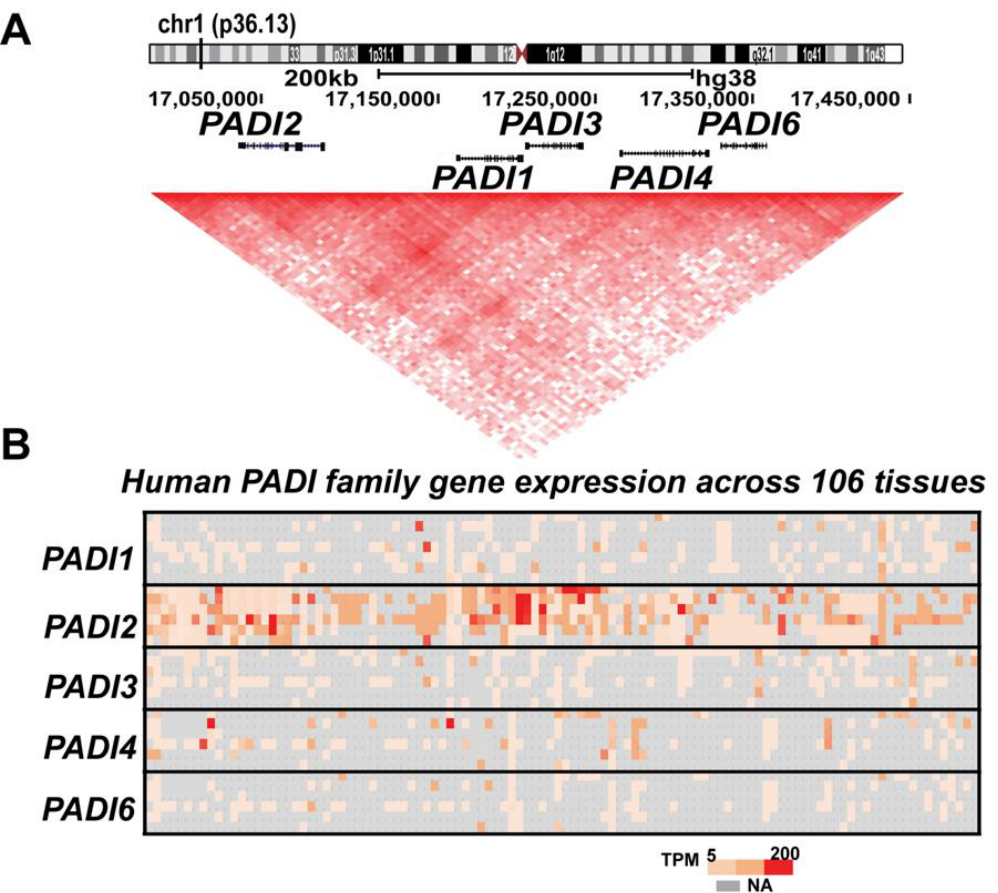
Figure 2. Human PADI gene family. ( A ). Five human PADIs genes ( PADI1 , PADI2 , PADI3 , PADI4 and PADI6 ) are present in the p36.13 of chromosome 1. Among the family members, PADI2 gene is the only one in reverse direction. PADI loci encompasses the same topological associated domain (TAD) in T47D breast cancer cells. ( B ). PADI2 is widely expressed among family members. Heatmap representing the basal expression level of all five human PADI members across 106 human tissues compiled from the gene expression atlas (https://www.ebi.ac.uk/gxa/home). Basal gene expression represented as TPM, transcripts per million from RNA-sequencing.